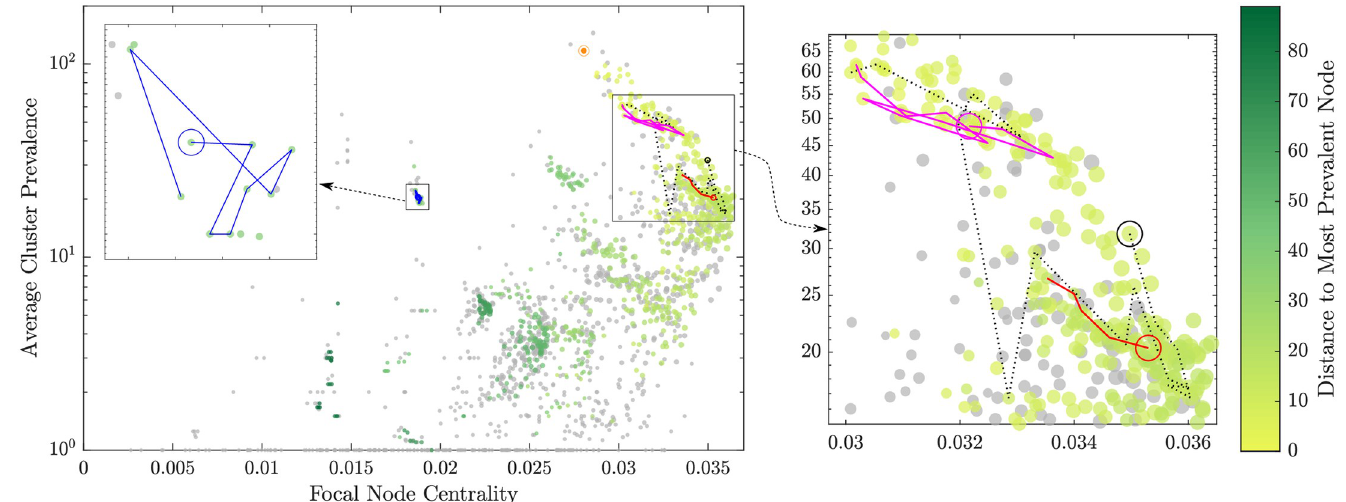
Fig 3. Structure-function relationship in the genotype networks, mapping the centrality of profiles (x-axis) and their average cluster prevalence (y-axis). The size of each point is proportional to the size of its corresponding cluster. The centrality is measured with respect to the complete undirected genotype network. The colour shows the genetic distance of a profile to the reference profile (in orange, see Fig 2), with grey points indicating disconnected profiles. The gradient of colouring indicates an evolutionary trend from low-to-high centrality (left to right) and then a reverse in direction from high to medium centrality (right to left). During this trend, the average prevalence of the node clusters is increasing. Consequently, two branches can be distinguished: (i) from weakly-prevalent and peripheral nodes (the bottom-left corner), towards a region comprising the profiles with high centrality (between 0.033 and 0.036) and medium cluster prevalence (between 12 and 32.1), and (ii) from this region towards the reference profile (in orange), in the direction of increasing prevalence (bottom to top) but decreasing centrality (right to left). The three case studies are shown in magenta, blue, and red, as well as the longest path (dashed black), with the source profile of these paths circled with the colour of the